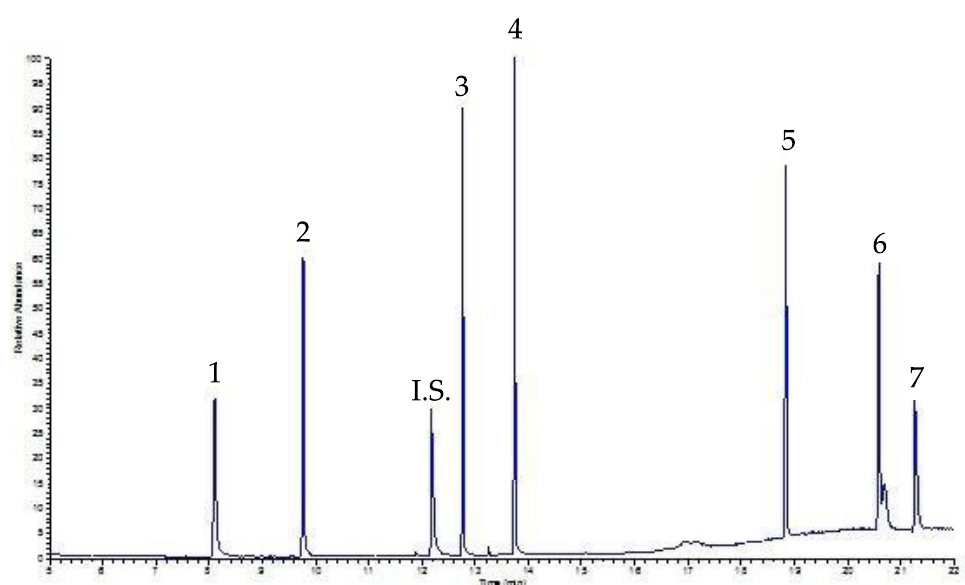
Figure 4. SPE-GC-FID chromatogram of a coffee sample spiked with 30 µ g mL − 1 of each PAE. Peaks: 1 DMP, 2 DEP, I.S. Internal Standard, 3 DiBP, 4 DBP, 5 DEHP, 6 DOP, 7 DDP; for experimental conditions: see text.